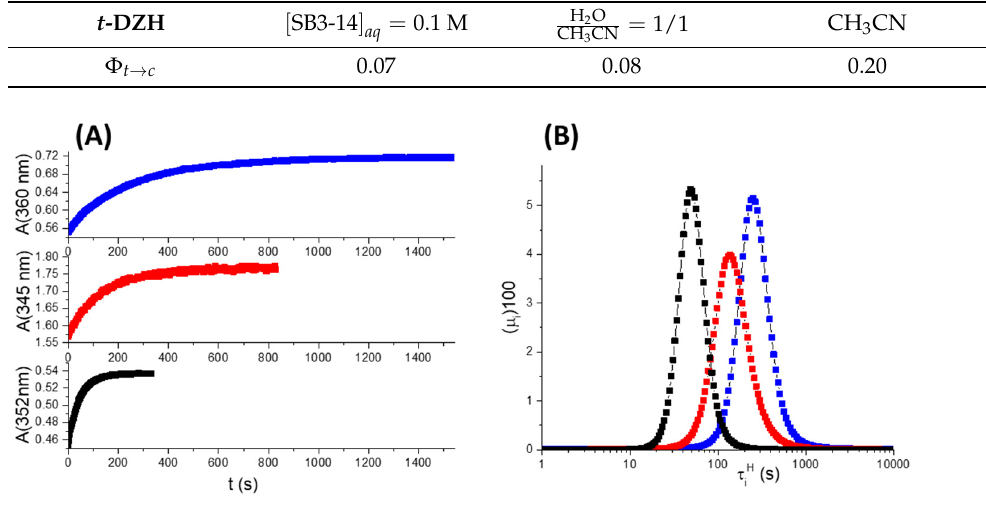
Figure 5. Graph ( A ): Kinetics of the thermal cis -to- trans isomerization for DZH in the aqueous micellar solution of SB3-14 0.1 M (blue trace); in H 2 O/CH 3 CN = 1/1 (red trace); in CH 3 CN (black trace). Graph ( B ): lifetimes distributions of the c -DZH conformers, determined through the maximum entropy method.